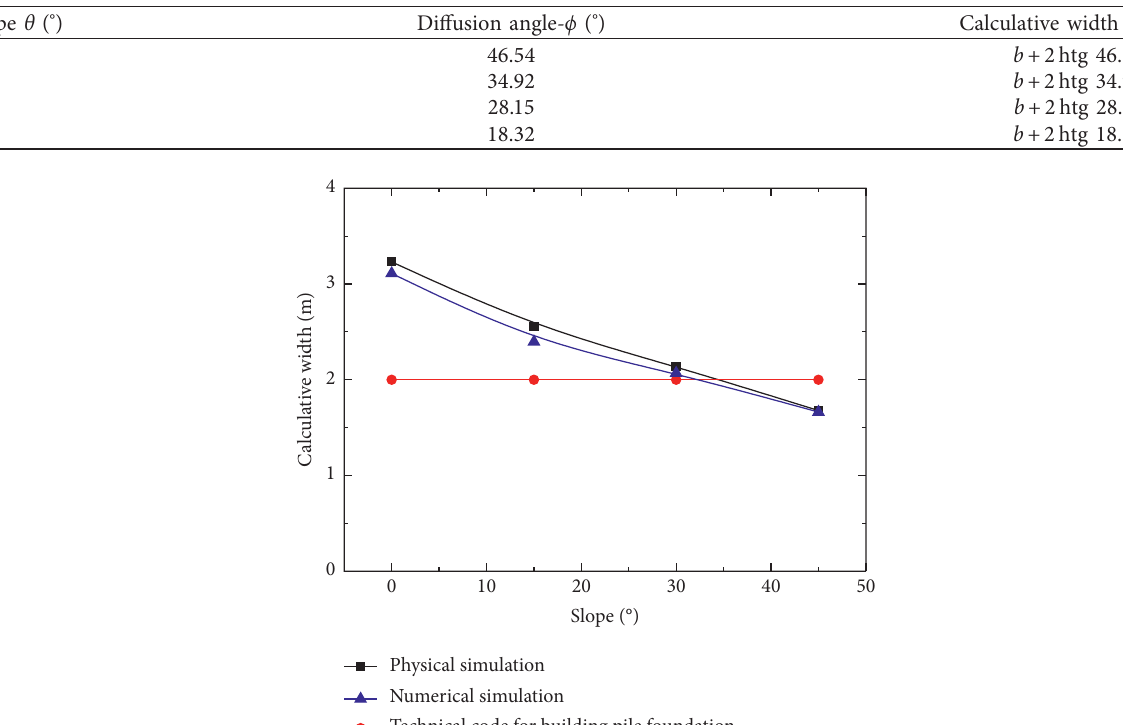
Table 7: Calculative width based on numerical simulation.